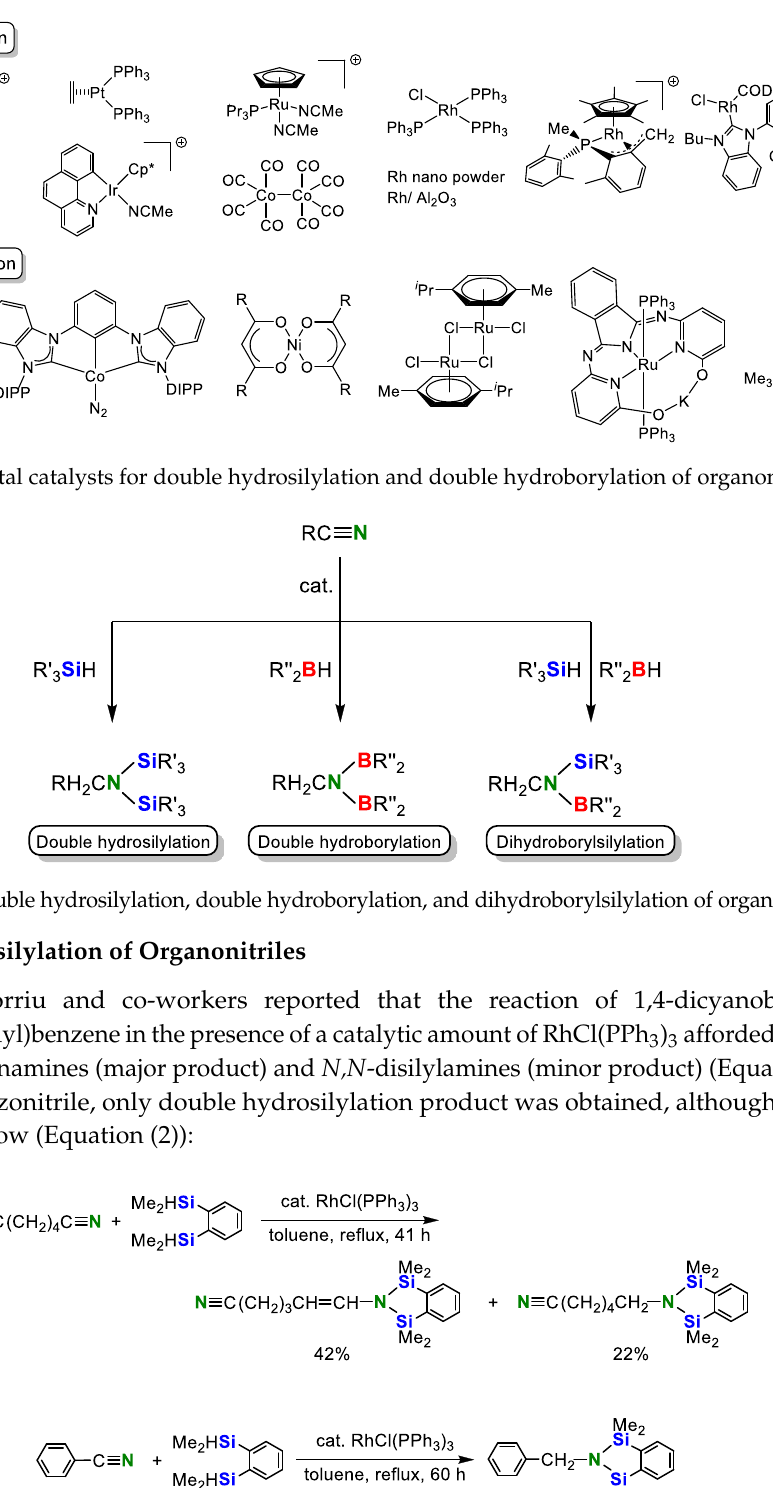
Figure 1. Metal catalysts for double hydrosilylation and double hydroborylation of organonitriles.